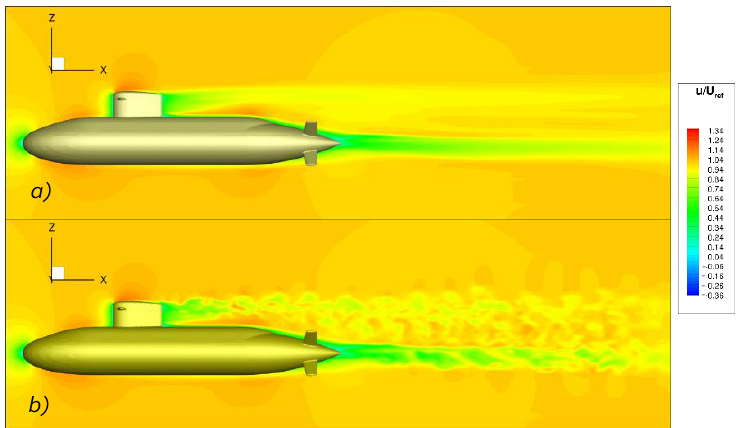
Figure 11. Non–dimensional instantaneous ( b ) and averaged ( a ) axial velocity component on the plane y = 0.